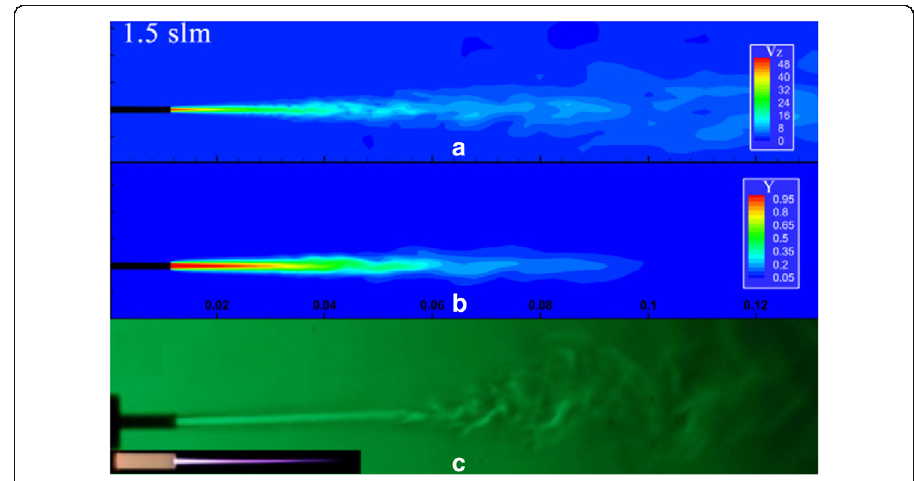
Fig. 3 Numerical simulations of ( a ) the axial velocity V z (ms − 1 ) and ( b ) helium mass fraction Y, compared with ( c ) an experimental schlieren image, for 1.5 slpm of He flow rate and the plasma in operation (20kV p-p ). Schlieren imaging was performed in a Z-type configuration setup with a high-power green light-emitting diode, two spherical mirrors and a Foucault knife-edge tester [44] © Deutsche Physikalische Gesellschaft. Reproduced by permission of IOP Publishing. CC